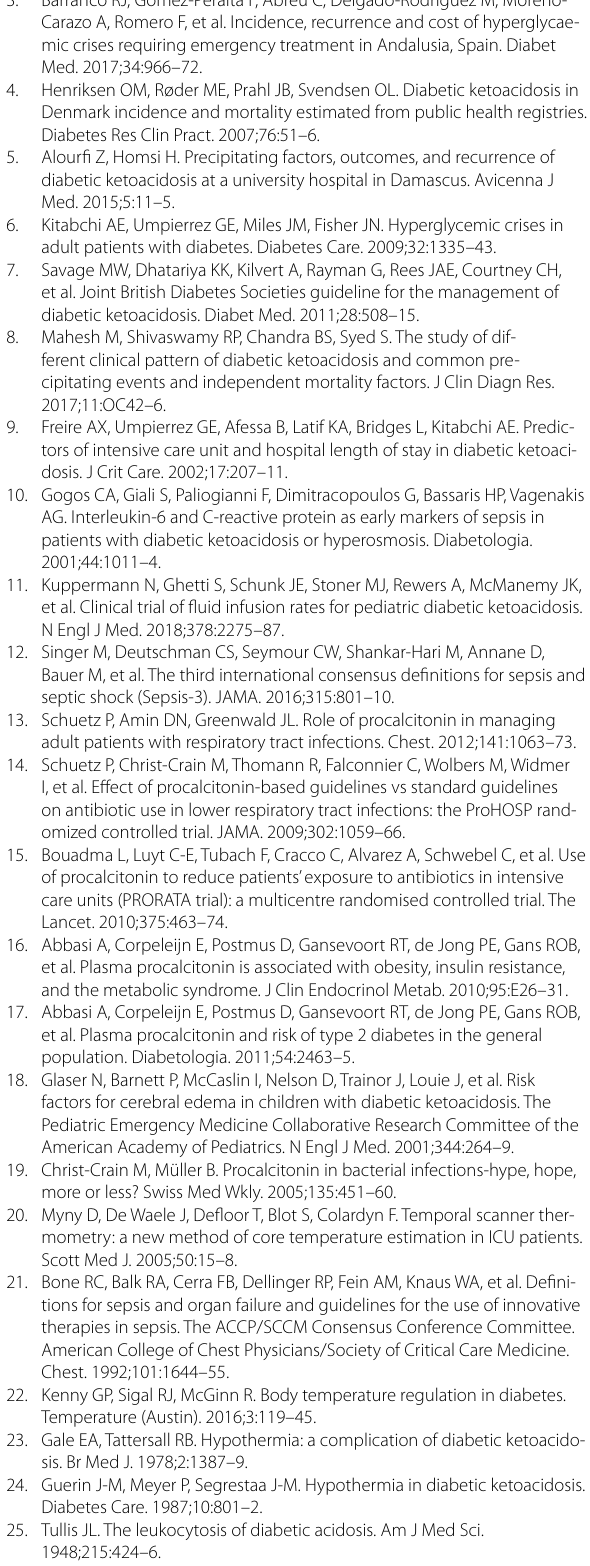
Additional file 1: Table S1. Sepsis markers in episodes with proven bacterial infection at admission and day 2 ( Univariate analysis ). Table S2. Sepsis markers in episodes without proven bacterial infection at admis- sion and day 2 ( Univariate analysis ). Figure S1. Receiver operating char- acteristics curve of procalcitonin at day 2. Figure S2. Receiver operating characteristics curve of whole blood count and temperature on day